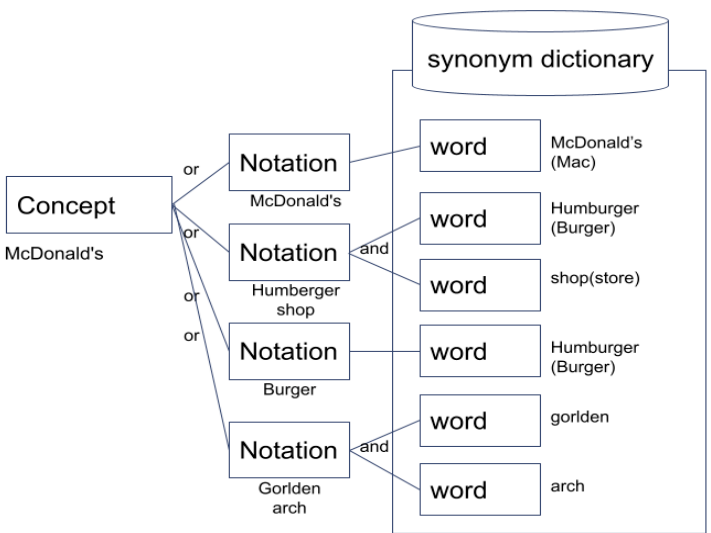
Figure 5. Notation blur of hamburger restaurant.